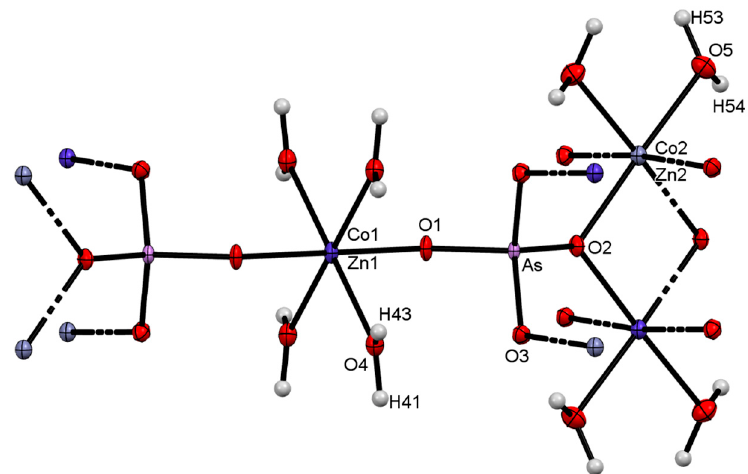
Figure 8. Topology of M1 , M2 , and As sites in Co-rich köttigite. Probability level for thermal ellipsoids: 50%. Labels of symmetrically equivalent atoms are omitted for clarity. Table 4. Atomic coordinates, equivalent isotropic displacement parameters, selected bond distances (Å) and angles ( ◦ ) in Co-rich köttigite. The multiplicities of bond lengths and angles are given in brackets. x y z U eq (Å 2